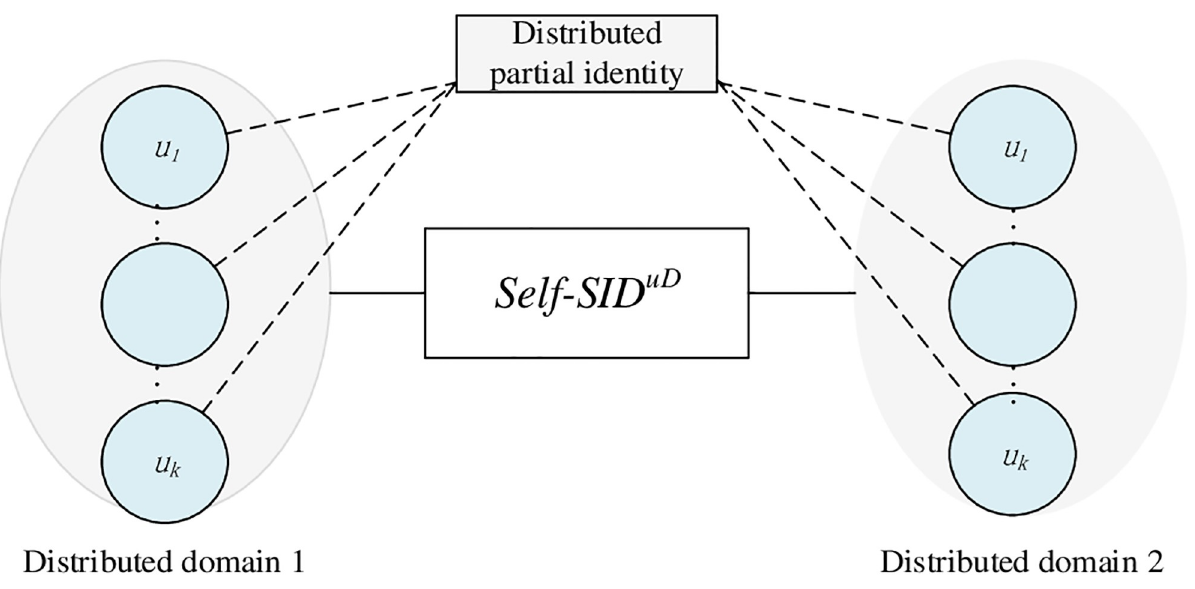
Fig 4. User partial identities distributed